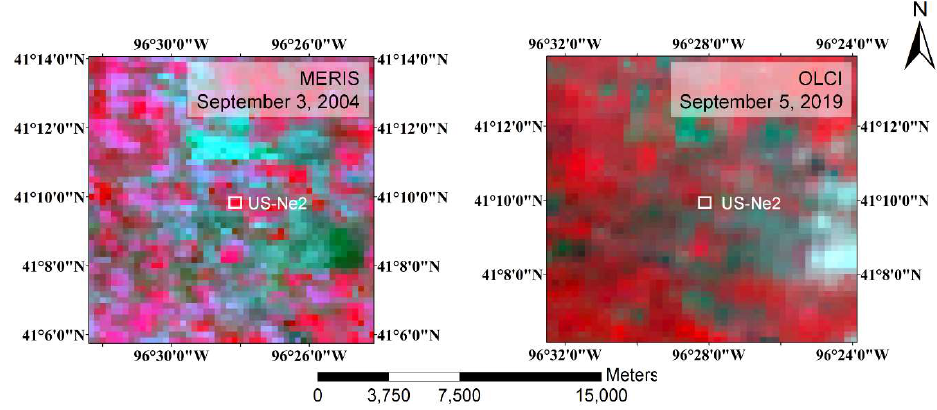
Figure 2. MERIS and OLCI images with an extent of 15 km by 15 km covering the US-Ne2 study site. The area marked with a solid white line in the center of the figure is the US-Ne2 site.